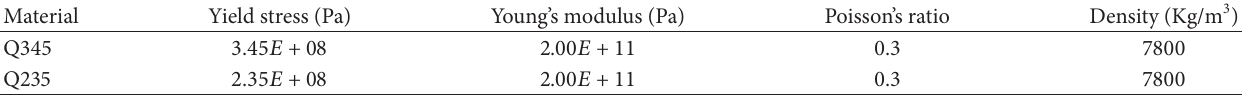
Table 1: Mechanical properties of Q345 and